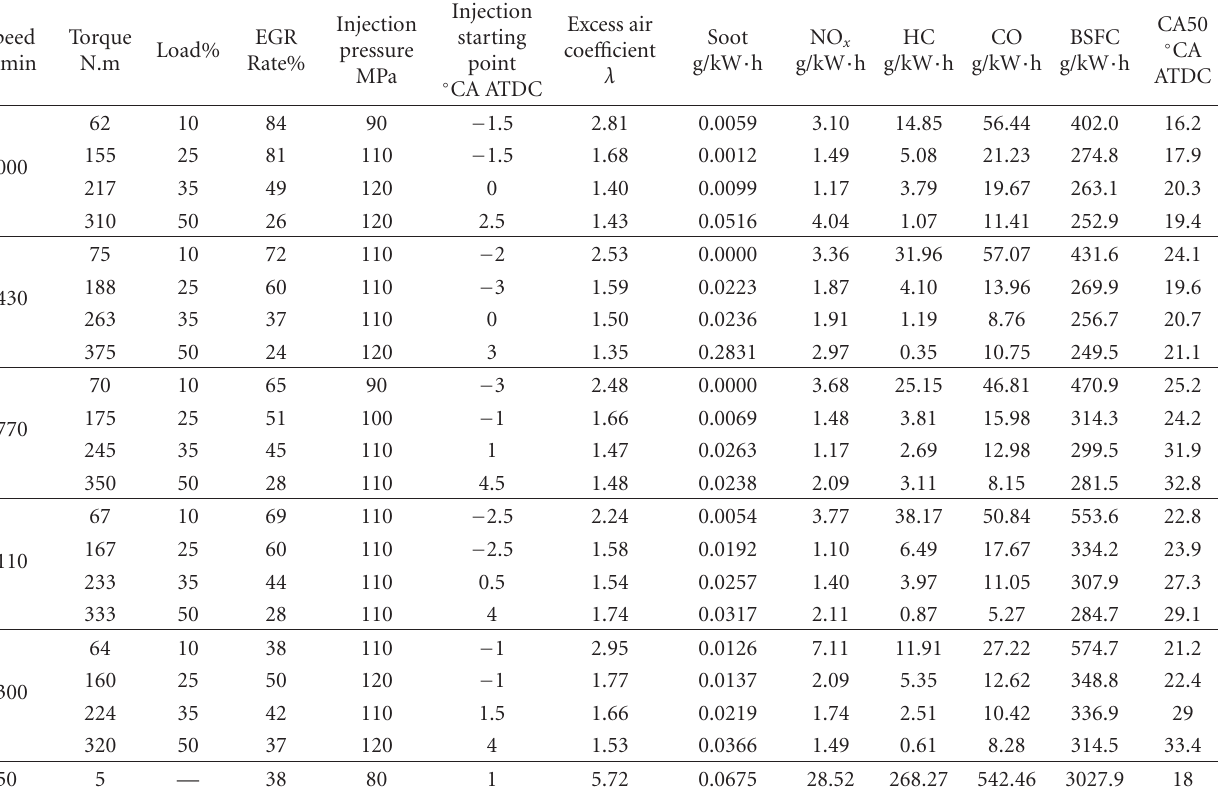
Figure 13: Cylinder pressure and heat release rate comparison between premixed combustion and original engine combustion. Table 9: Test result at di ff erent test